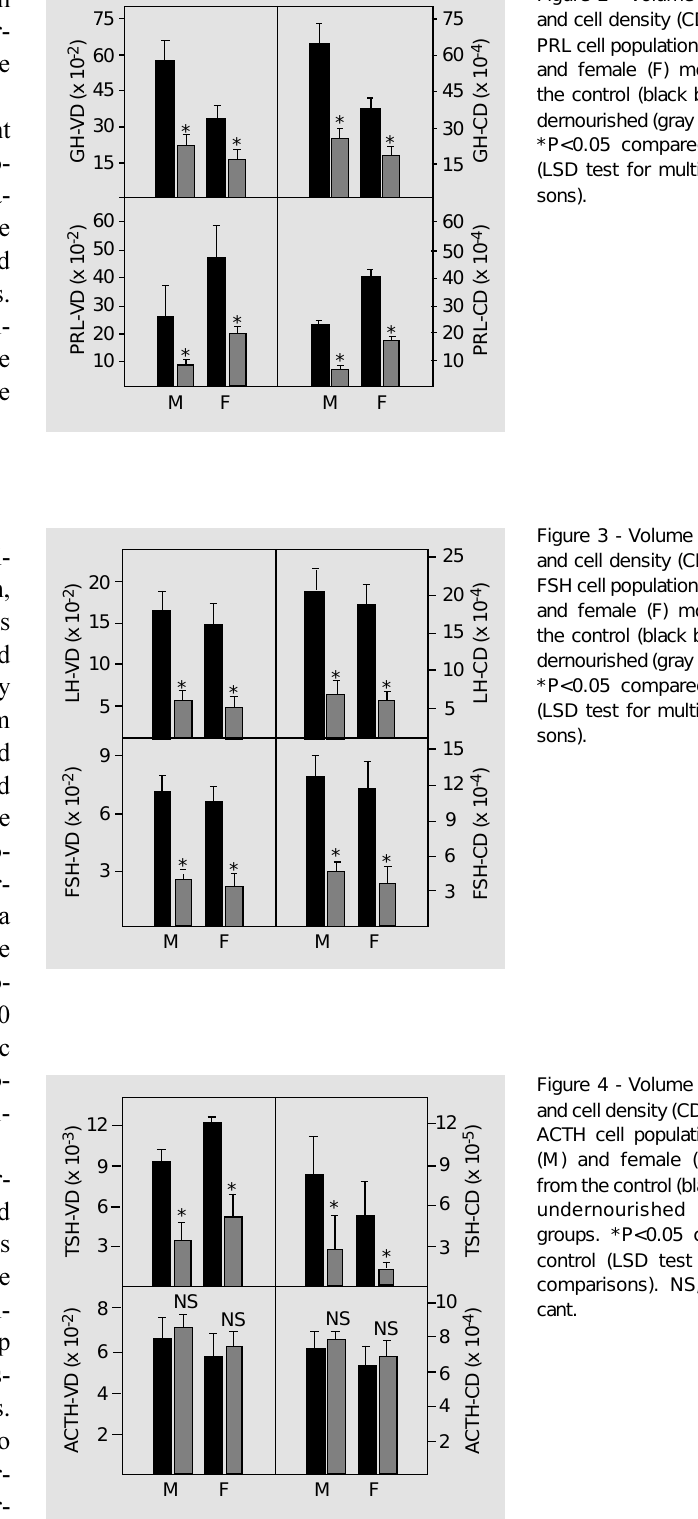
Figure 2 - Volume density (VD) and cell density (CD) of GH and PRL cell populations in male (M) and female (F) monkeys from the control (black bars) and un- dernourished (gray bars) groups. *P<0.05 compared to control (LSD test for multiple compari- sons).